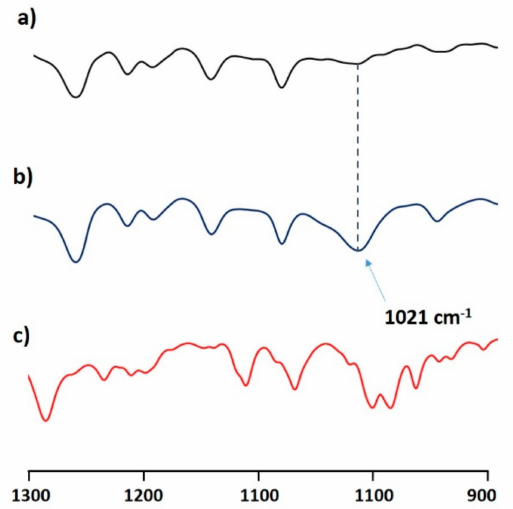
Figure 3. Fourier-Transformed Infrared spectra of ( a ) 3a mixed with Doxorubicin, ( b ) 3a not mixed with Doxorubicin, ( c )